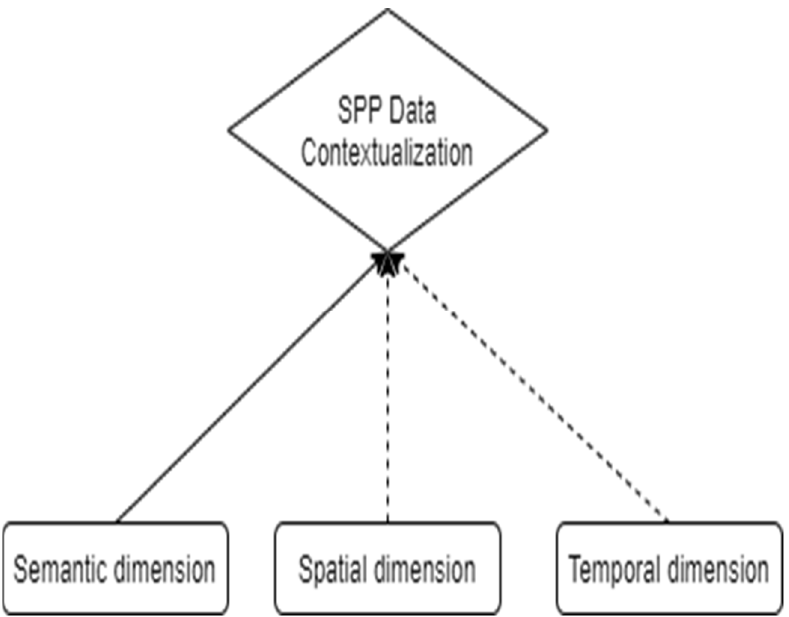
Figure 1. Theoretical framework—Semantic, spatial, and temporal SPP data contextualization.